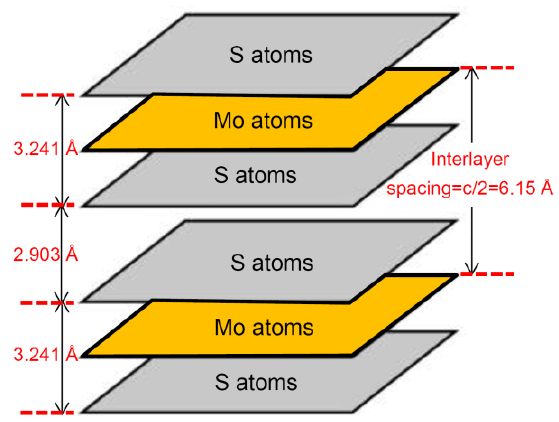
Figure 1. Distances between different layers in 2H MoS 2 .